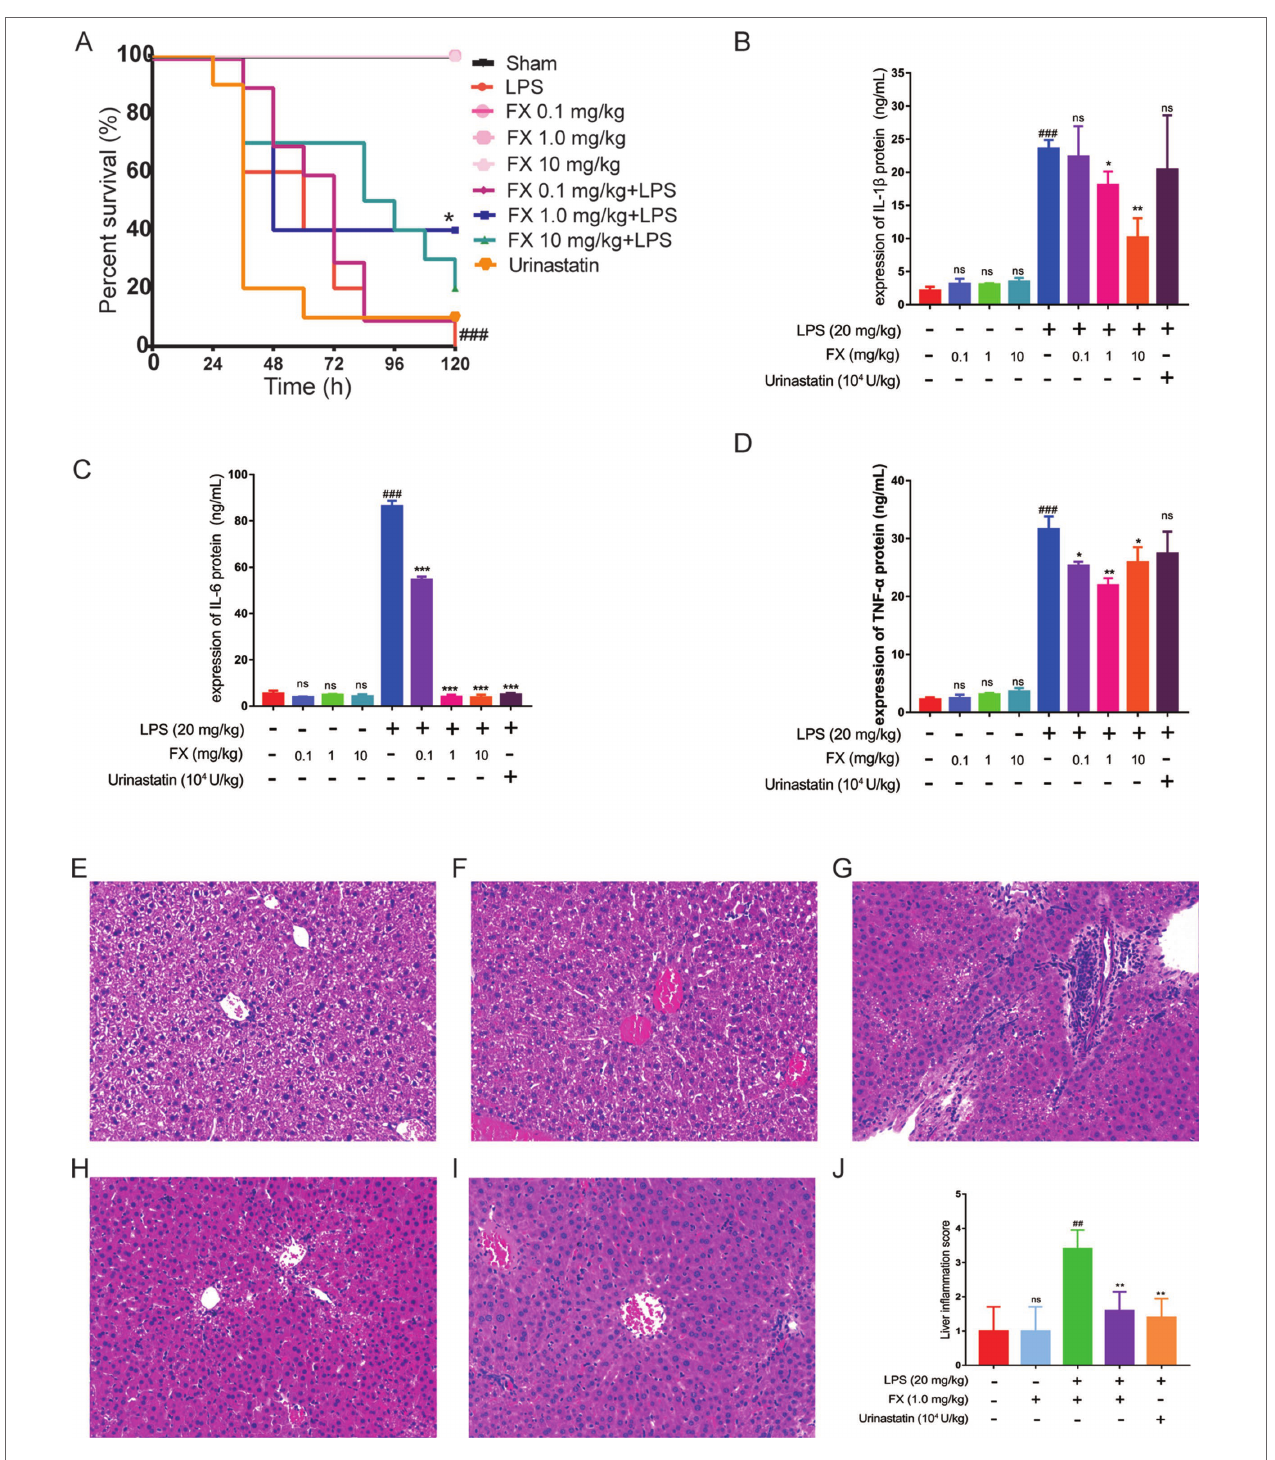
FIGURE 4 | Effects of FX on LPS-induced sepsis in mice. The mice were treated with FX (0.1–10 mg/kg) 2 h before the administration of lipopolysaccharide (LPS) (20 mg/kg, ip). Ulinastatin (10 4 U/kg) was used as a control. (A) The effects of different doses of FX on the survival of LPS-treated mice (n = 10). (B, C, D) The serum levels of the inflammatory factors TNF- α , IL-1 β , and IL-6 were measured using the ELISA kits (n = 6). The effect of FX on liver tissue histopathological changes in LPS-induced septic mice. Histopathologic sections of liver tissues (H&E, ×200). (E) Liver tissues from control, (F) FX (1.0 mg/kg), (G) LPS (20 mg/kg), (H) LPS (20 mg/kg) + FX (1.0 mg/kg), (I) LPS (20 mg/kg) + Urinastatin groups (10 4 U/kg) and (J) the pathological scores was evaluate in LPS-induced septic mice. The data were analyzed by the one-way ANOVA, followed by Tukey’s post hoc test. (##) p < 0.01, (###) p < 0.001, significantly different when compared with that of the control group, ns: not significant. ( ∗ ) p < 0.05, ( ∗∗ ) p < 0.01, and ( ∗∗∗ ) p < 0.001, significantly different when compared with that of the LPS